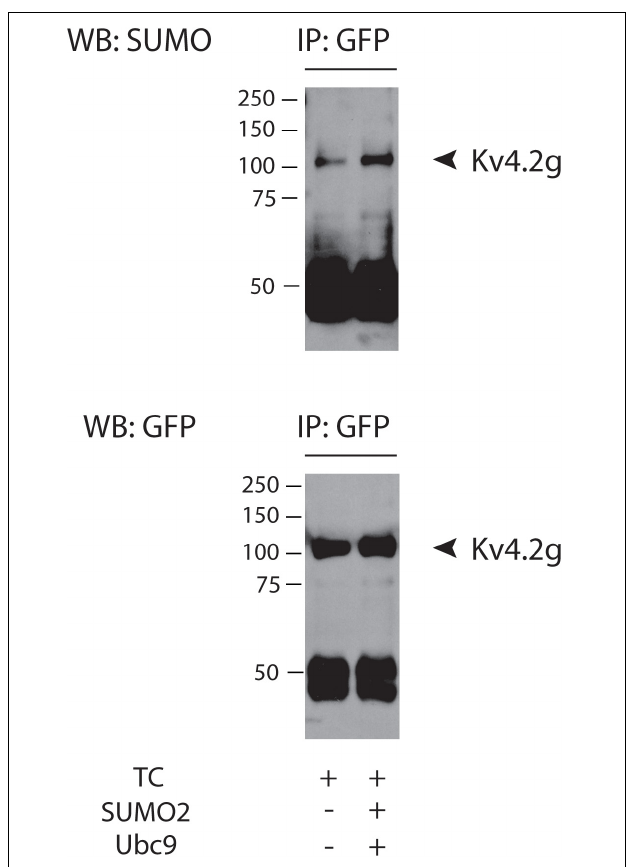
FIGURE 1 | Kv4.2g is SUMOylated in the TC. Kv4.2g was co-expressed with HA-KChIP2a and HA-DPP10c in HEK cells with (+) or without (–) co-transfection of SUMO2 + Ubc9. Anti-GFP IPs were followed by western blotting. Blots were probed with anti-SUMO, and then stripped and reprobed with anti-GFP. Note the band at ∼ 50 kD represents the antibody used in the